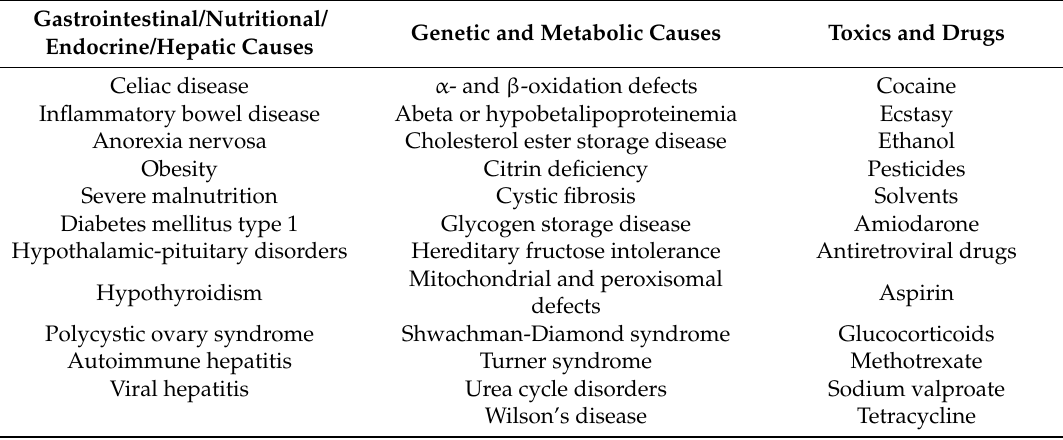
Table 1. Fatty liver etiologies to be considered against a diagnosis of pediatric non-alcoholic fatty liver disease (NAFLD)/non-alcoholic steatohepatitis